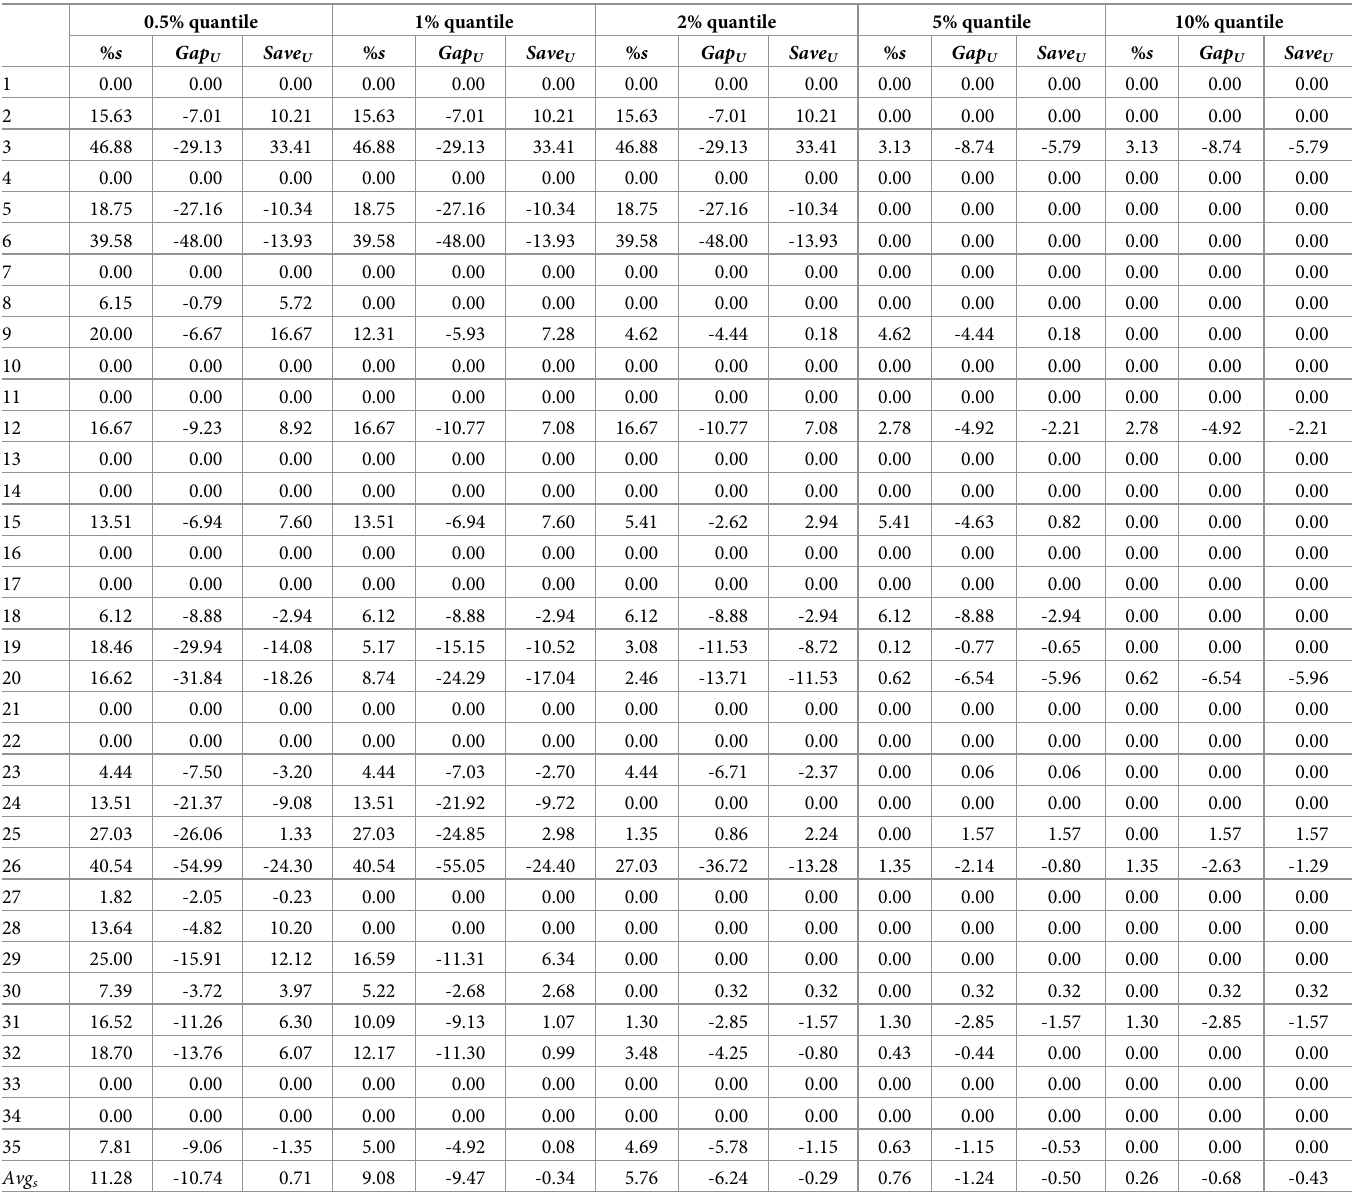
Table 4. Computational results for small-size instances with different values of λ